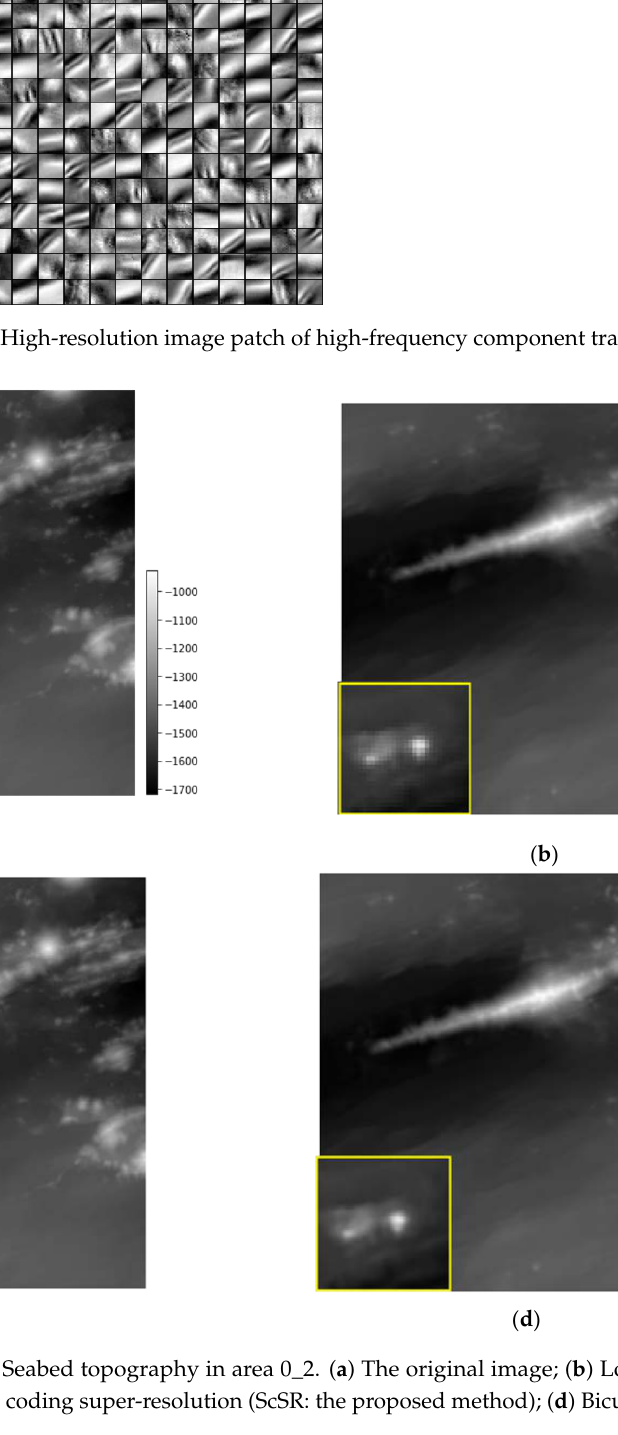
( b ) Figure 6. Residual images between the super-resolution images and original image of the area 0_2. ( a ) ScSR (RMSE: 1.157 m); ( b ) Bicubic interpolation (RMSE: 1.713 m). The same colour scale is used in both images. Table 1. RMSEs for eight regions reconstructed using the dictionaries learned in the other seven other sea areas, the RMSEs for bicubic interpolation, and their ratio. The unit of RMSE is metre in this table. Reconstruct Area